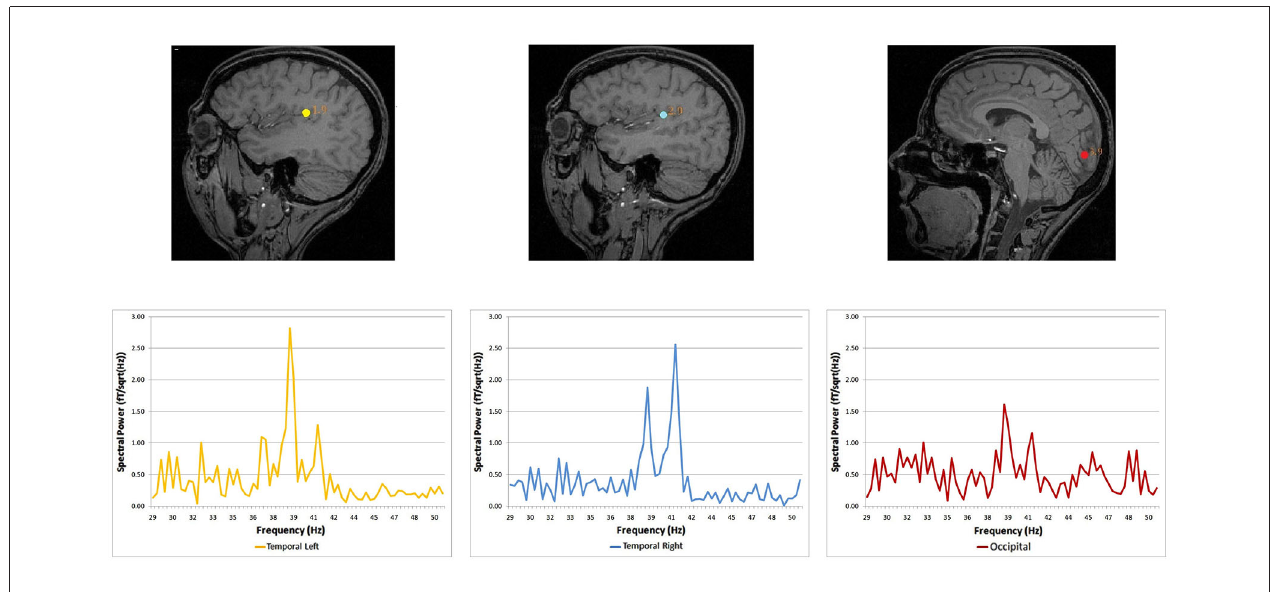
the dichotic condition, together with a source in the occipital cortex. Corresponding spectral responses are represented for each dipolar source—left and right temporal areas and the occipital area (Lazzouni et al.,